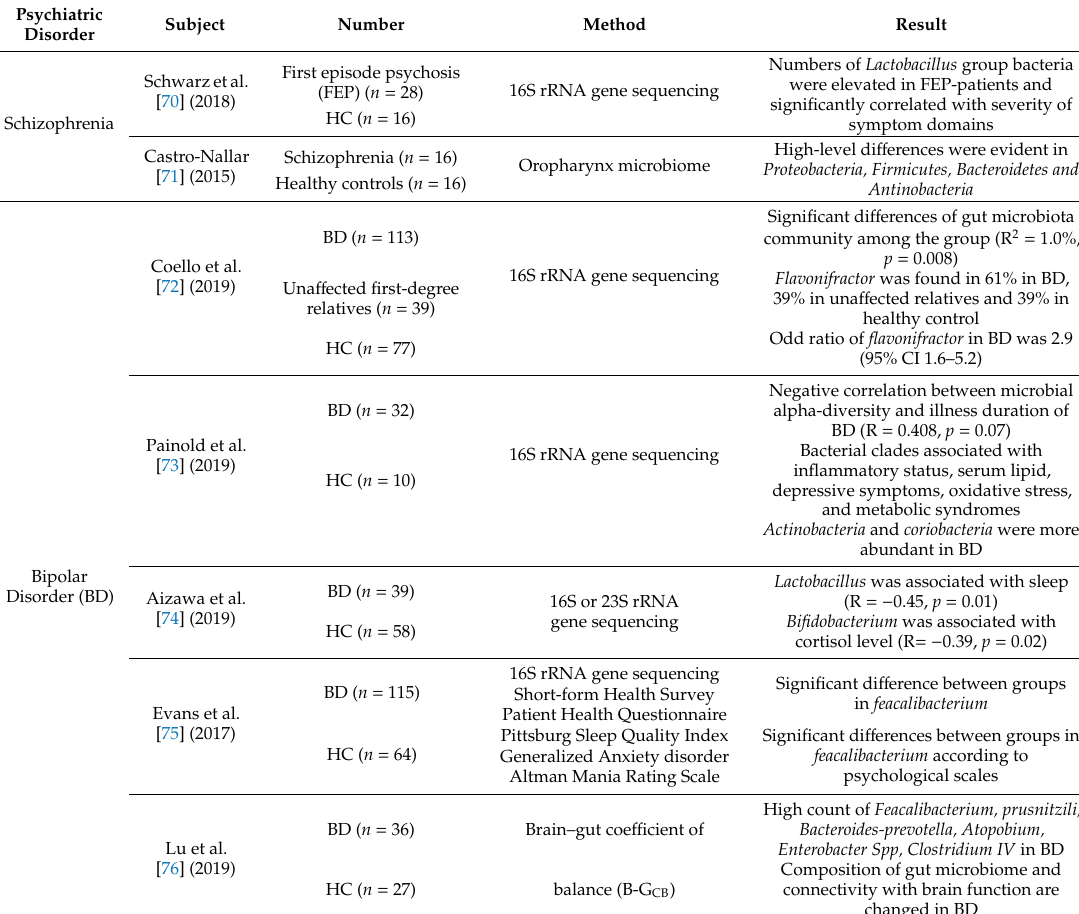
Table 3. Characteristics of prior studies investigating the relationship between microbiome and Schizophrenia, Bipolar